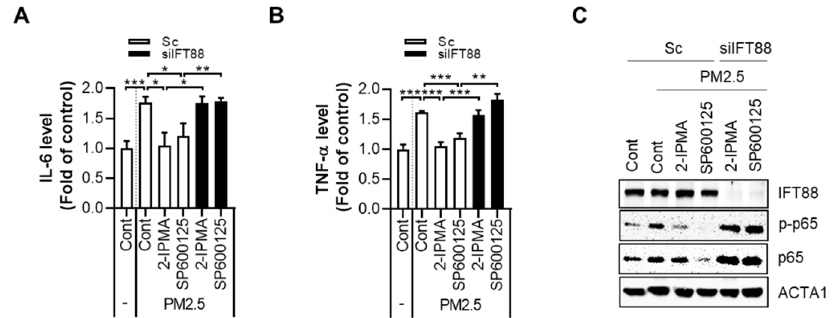
Figure 4. Primary cilia by 2-IPMA decrease inflammatory responses by PM2.5 in normal dermal fibroblasts. ( A - C ) Normal dermal fibroblasts transfected with either scrambled siRNA (Sc) or siRNA against IFT88 (si IFT88 ) were further exposed to PM2.5 (50 μ g/mL) with 2-IPMA (100 μ M) or SP600125 (10 μ M) for 24 h. Then, the expression levels of inflammatory cytokines, IL-6 ( A ) and TNF- α ( B ), in the culture condition were measured using an ELISA assay. The cells were harvested and analyzed by Western blotting with the indicated antibodies ( C ). Data are presented as the mean ± SEM ( n = 3, * p < 0.05, ** p < 0.01, *** p < 0.005).